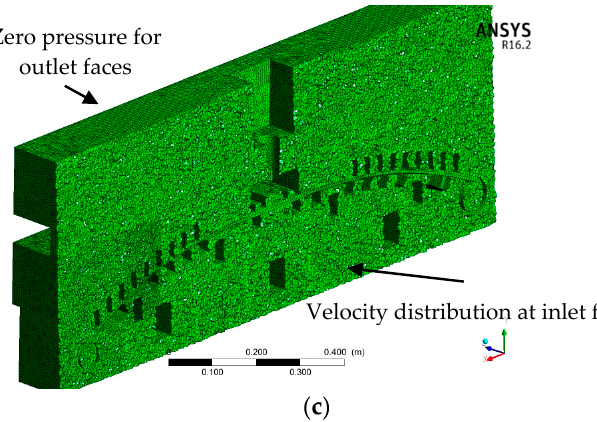
Figure 5. Subdomains and boundary conditions: ( a ) discretized feeder, ( b ) discretized tank, and ( c ) discretized virtual box, all with cut view planes. The footprint of shaper table, downholders and leaf spring is shown.